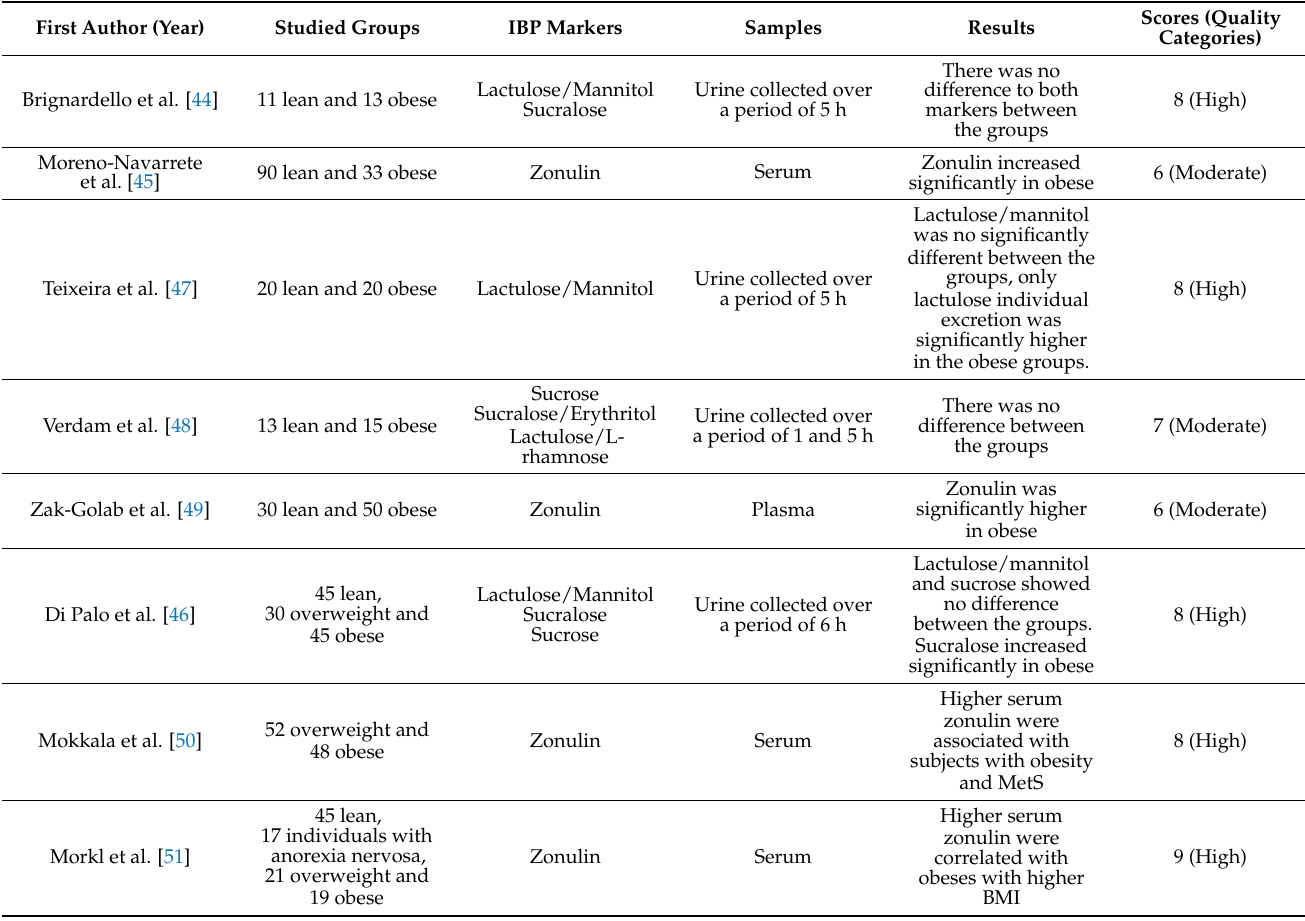
Table 2. Results of intestinal barrier permeability (IBP) evaluation and critical